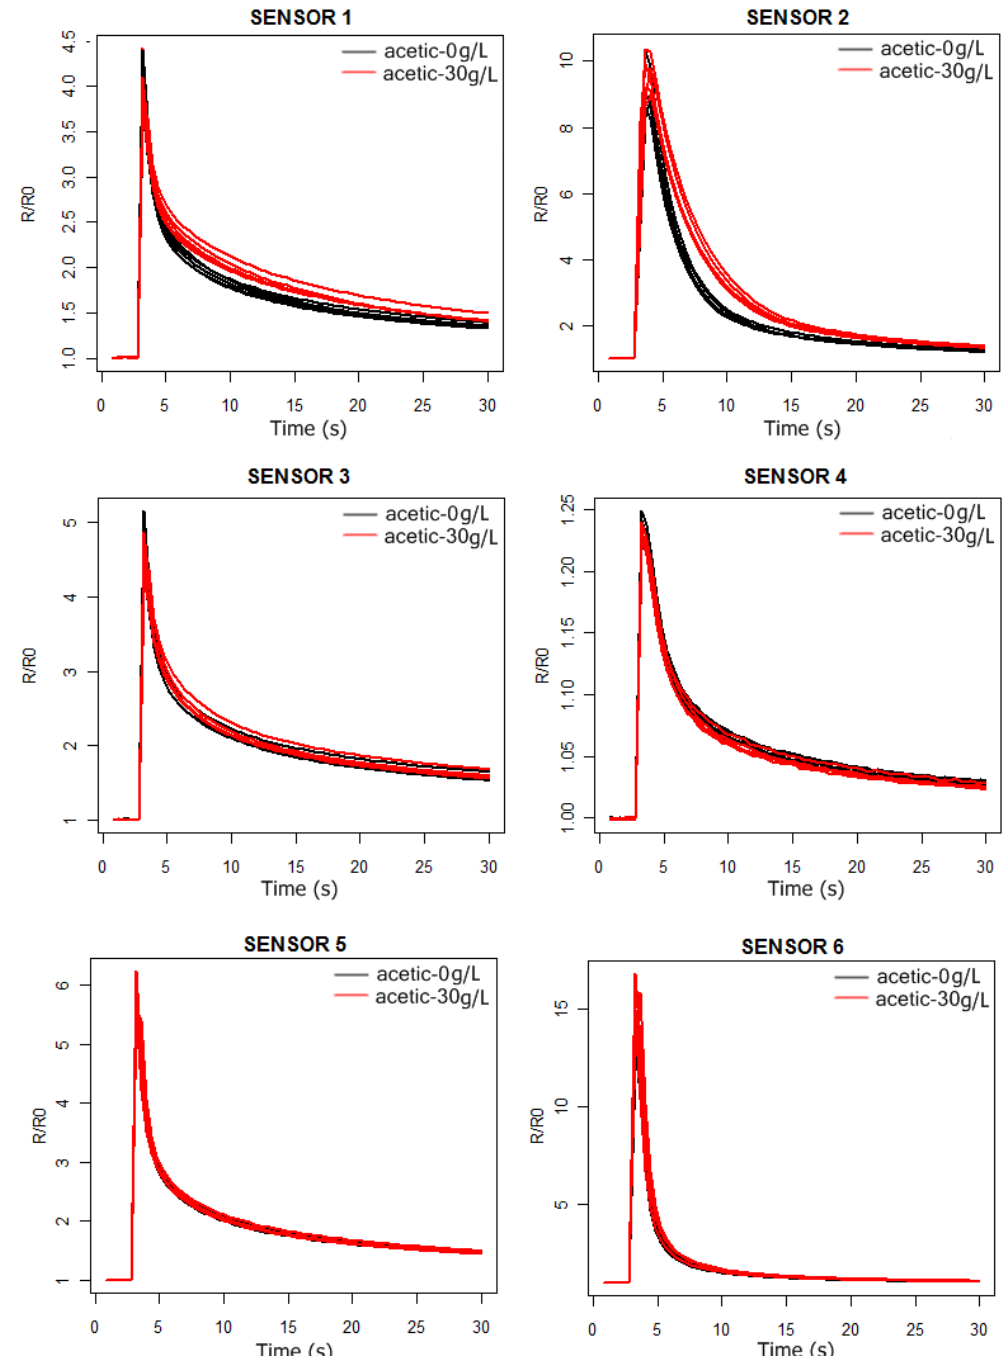
Figure 3. Sensor 1–6 response curves of the PEN3 electronic nose. Black: 10% aqueous ethanol solution. Red: 10% aqueous ethanol solution doped with acetic acid 30